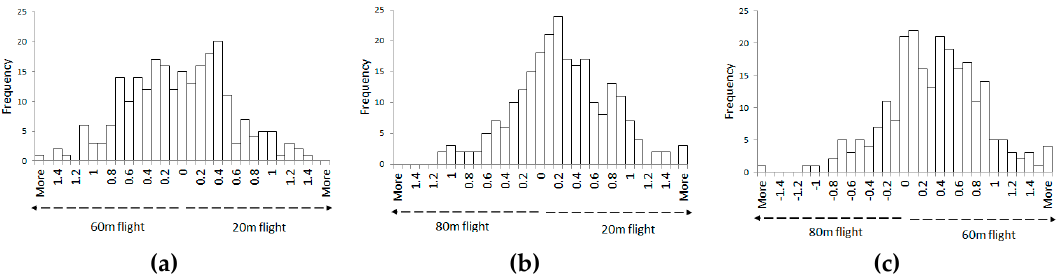
Figure 9. Scatterplot to compare crown projected area (CPA) diameter measured from different altitudes: ( a ) 20 m and 60 m, ( b ) 20 m and 80 m, and ( c ) 60 m and 80 m. A plot between ground measured CPA and UAV estimated CPA at flight altitude of ( d ) 20 m, ( e ) 60 m, and ( f ) 80 m.